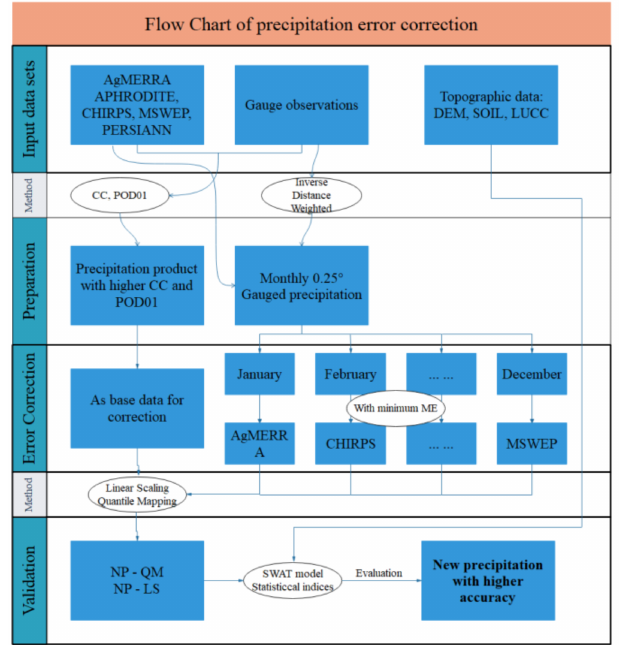
Figure 3. Flow chart of precipitation error correction for this study (CC: correlation coefficient, POD01: the probability of detection for precipitation and without precipitation, SWAT: Soil and Water Assessment Tool, NP: new precipitation products, QM: quantile mapping, LS: linear scaling).